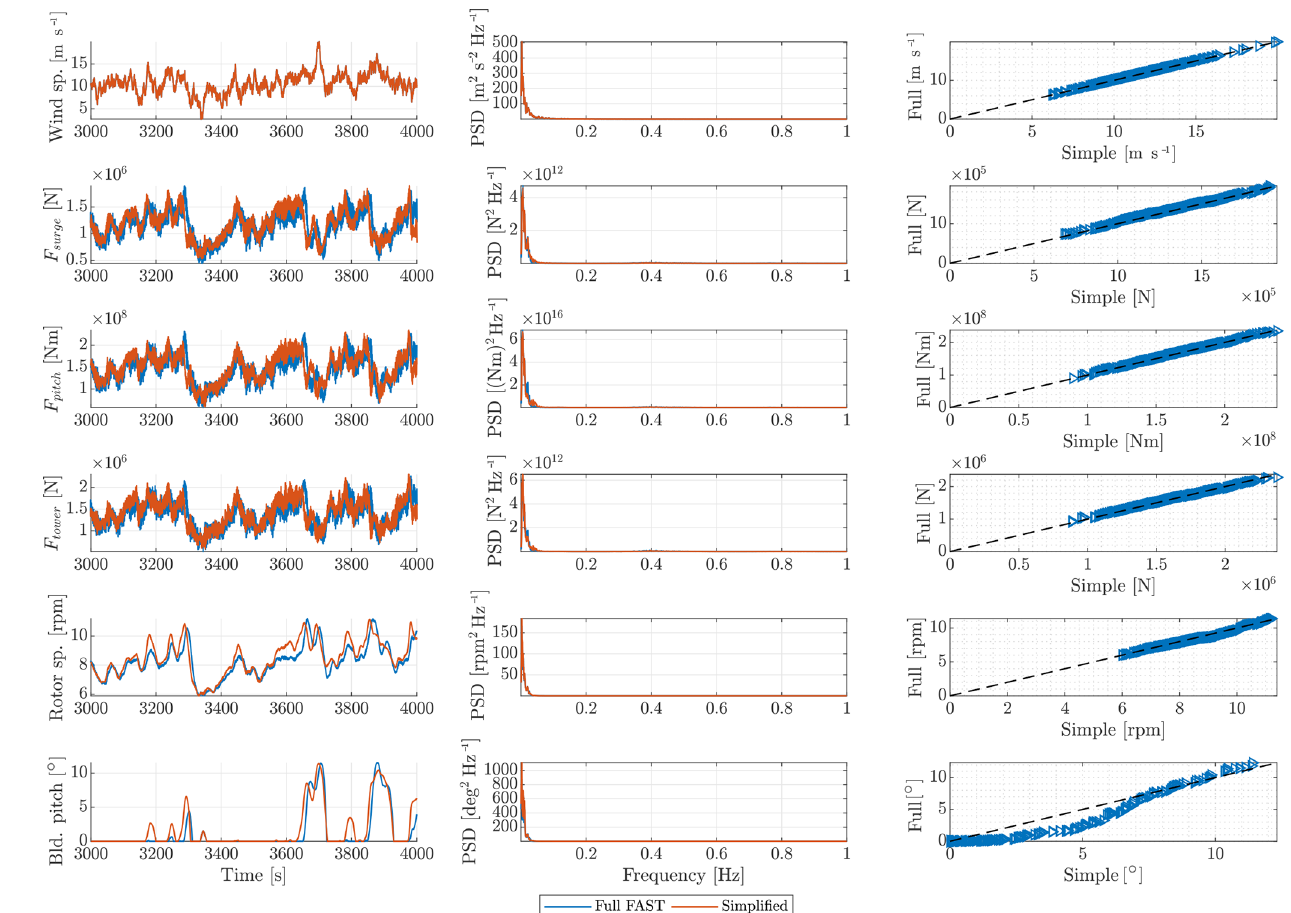
Figure 13. Extracted aerodynamic forcing applied in the surge, pitch and tower deflection degrees of freedom and turbine operational data for DLC 1.3 with 10 . 3ms − 1 mean wind speed. Left: time series outline. Middle: corresponding power density spectrum (PDF). Right: peak values (sorted) for the full FAST computations as a function of the corresponding maximum values in the simplified